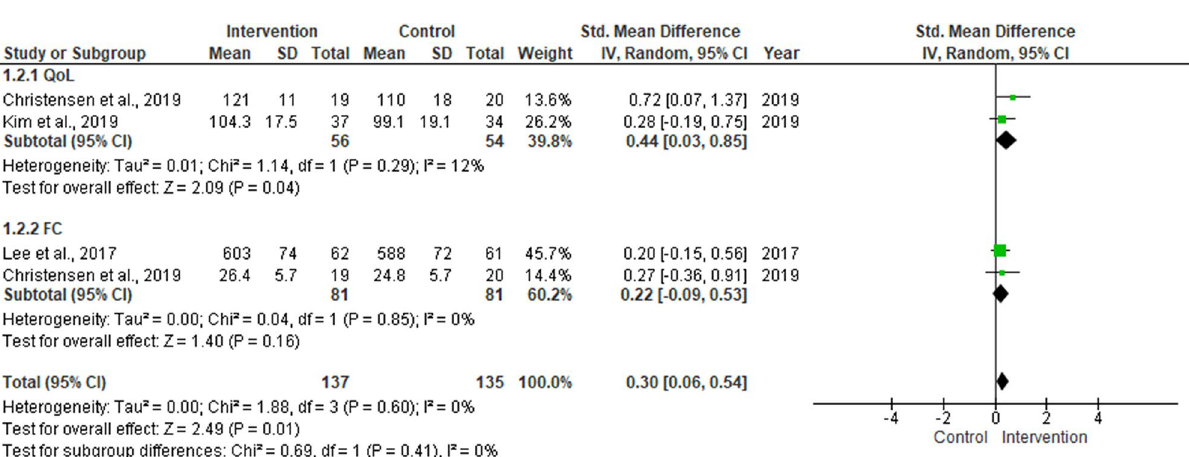
Figure 3. Sensitivity analysis of quality of life (QoL) and functional capacity (FC) measured in randomized controlled trials that conducted home-based exercise intervention with ≥ 80% adherence for colorectal cancer